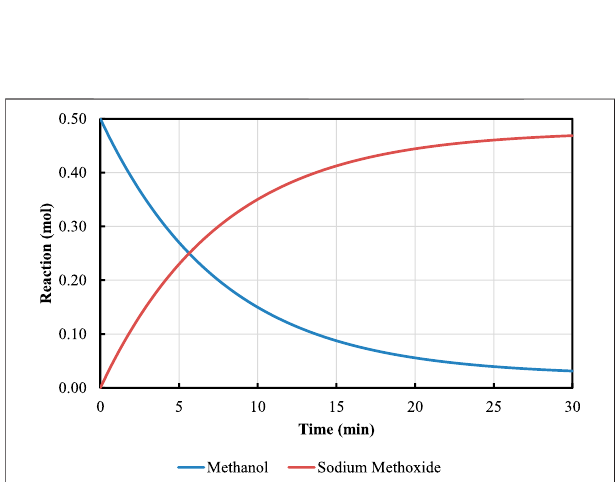
FIGURE 6 | Consumption of methanol and production of the methoxide with time, experiment #